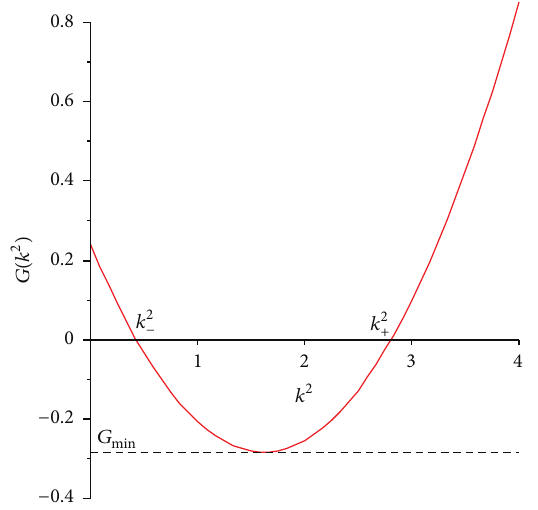
Figure 3: Variation of dispersion relation of model (5) for different 𝐷 = −1.6 < 𝐷 T 𝐷 12 : (A) 12 12 , the Turing instability occurs; (B) = −0.31 , the critical Turing value; and (C) 𝐷 𝐷 T 12 = + Turing instability decays. Other parameters values are fixed as (27) in the